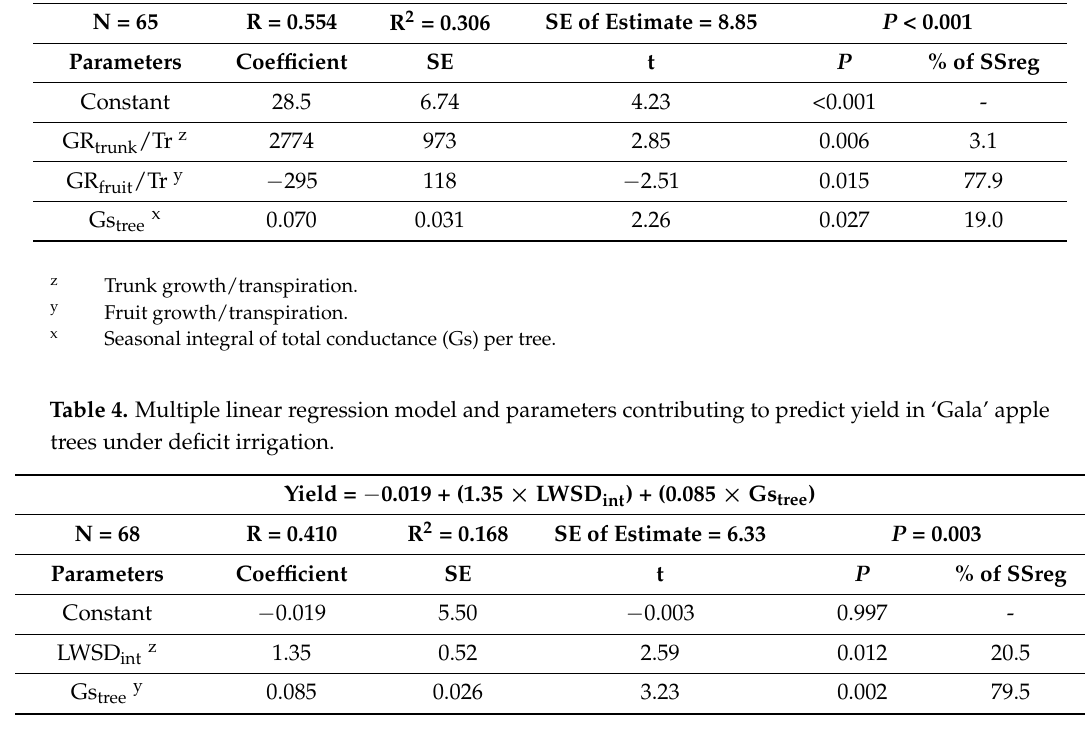
LWSD int is leaf water saturation deficit integrated across the irrigation period. y Seasonal integral of total conductance (Gs) per